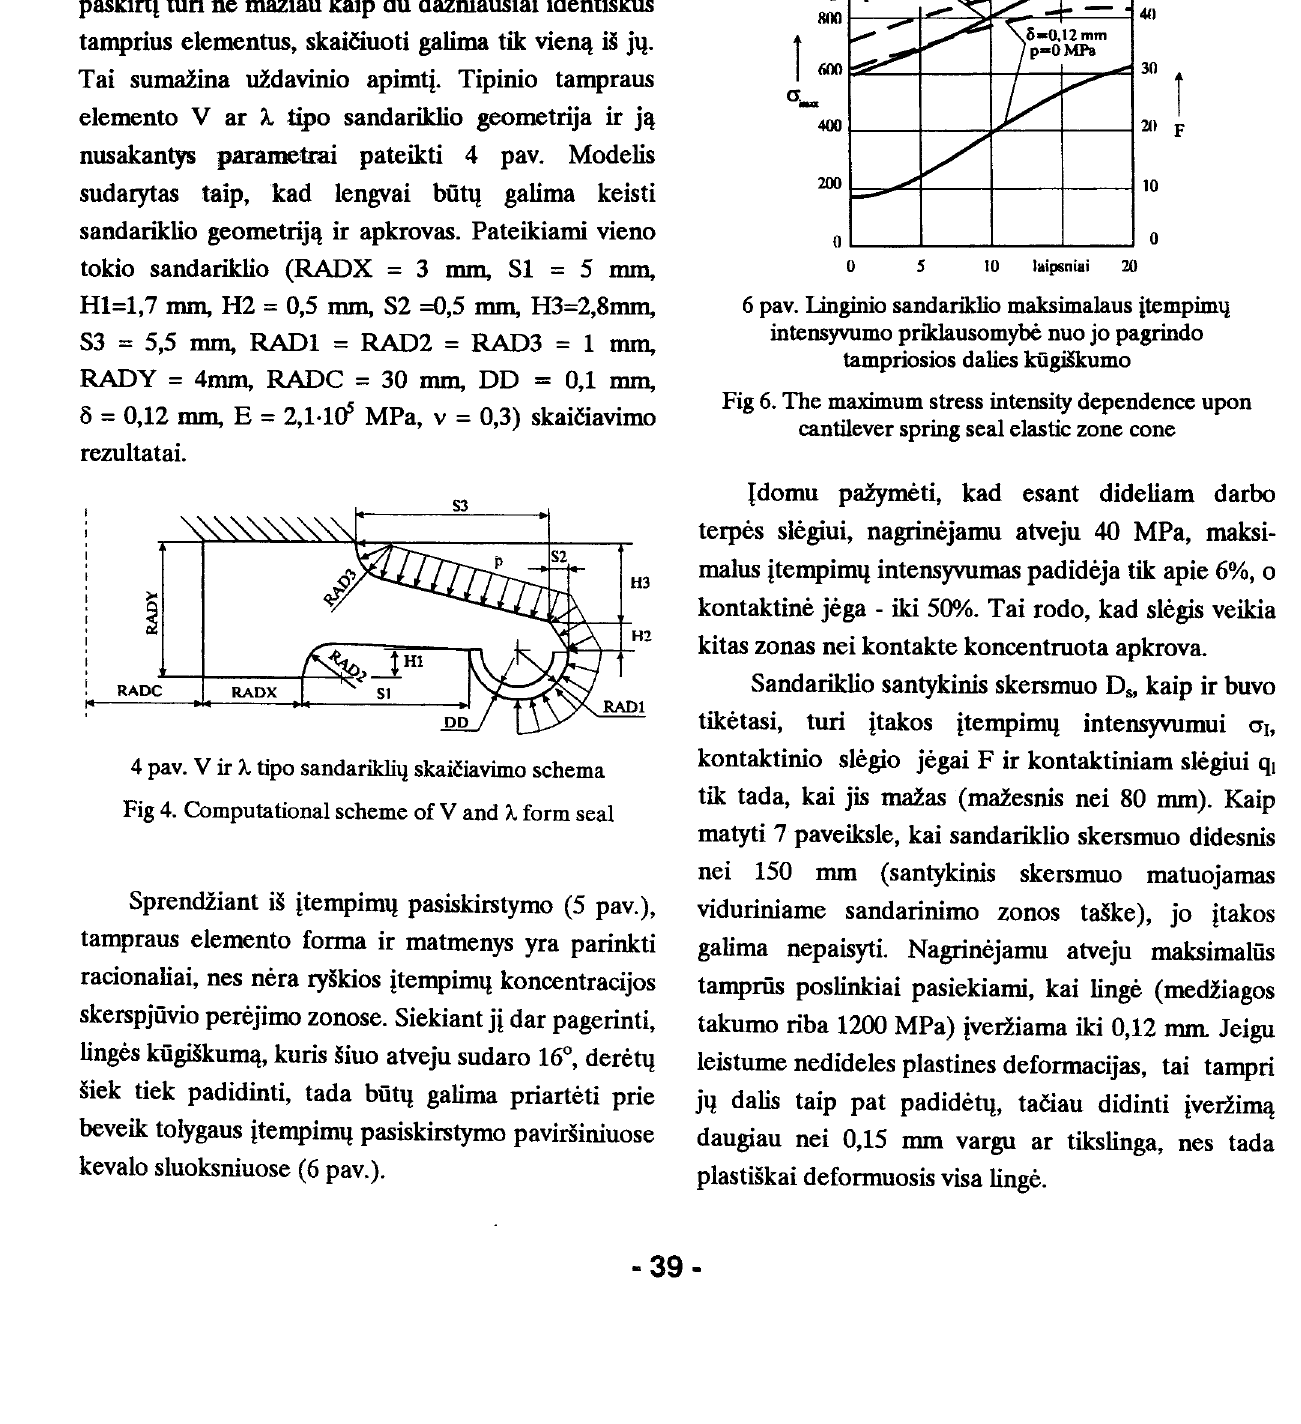
leistume nedideles plastines deformacijas, tai tampri jq dalis taip pat padidetq, taciau didinti ivedim~t daugiau nei 0,15 mm vargu ar tikstinga, nes tada plastiskai deformuosis visa